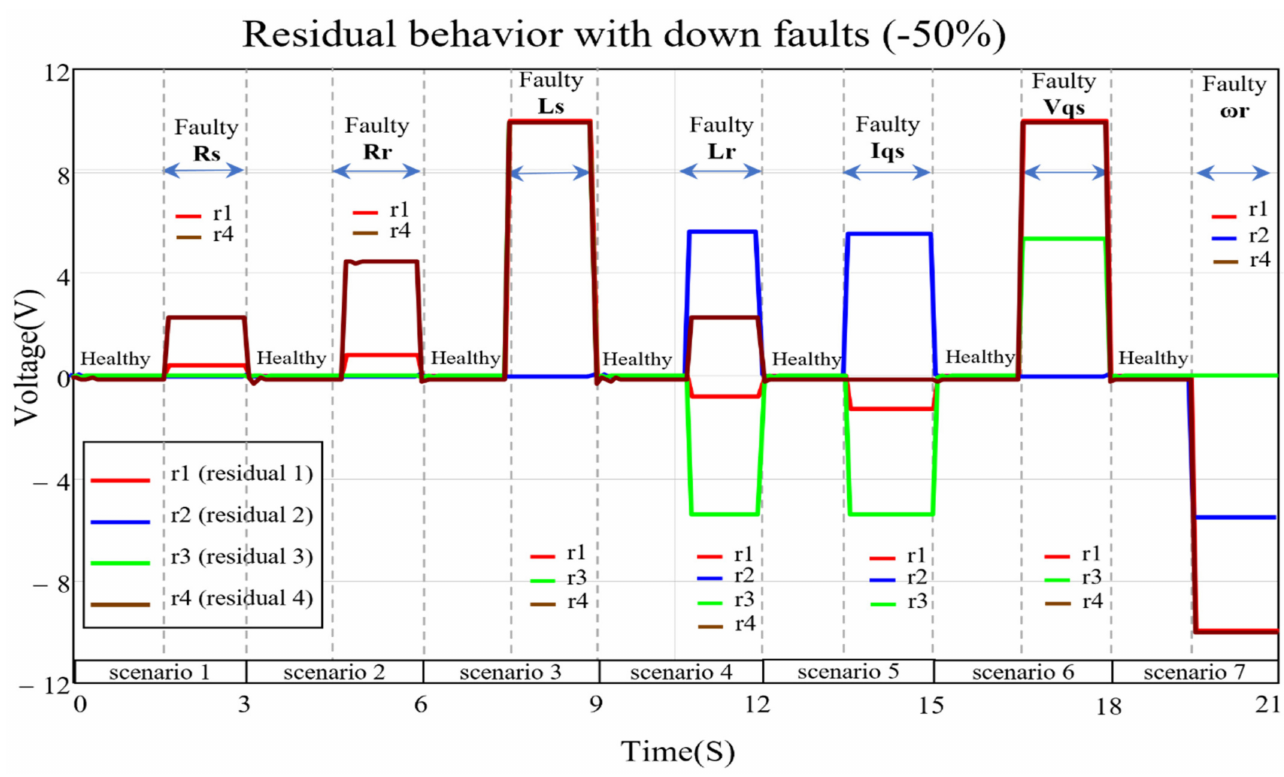
Figure 5. Residual behavior with up parametric variation to +50% of nominal value.